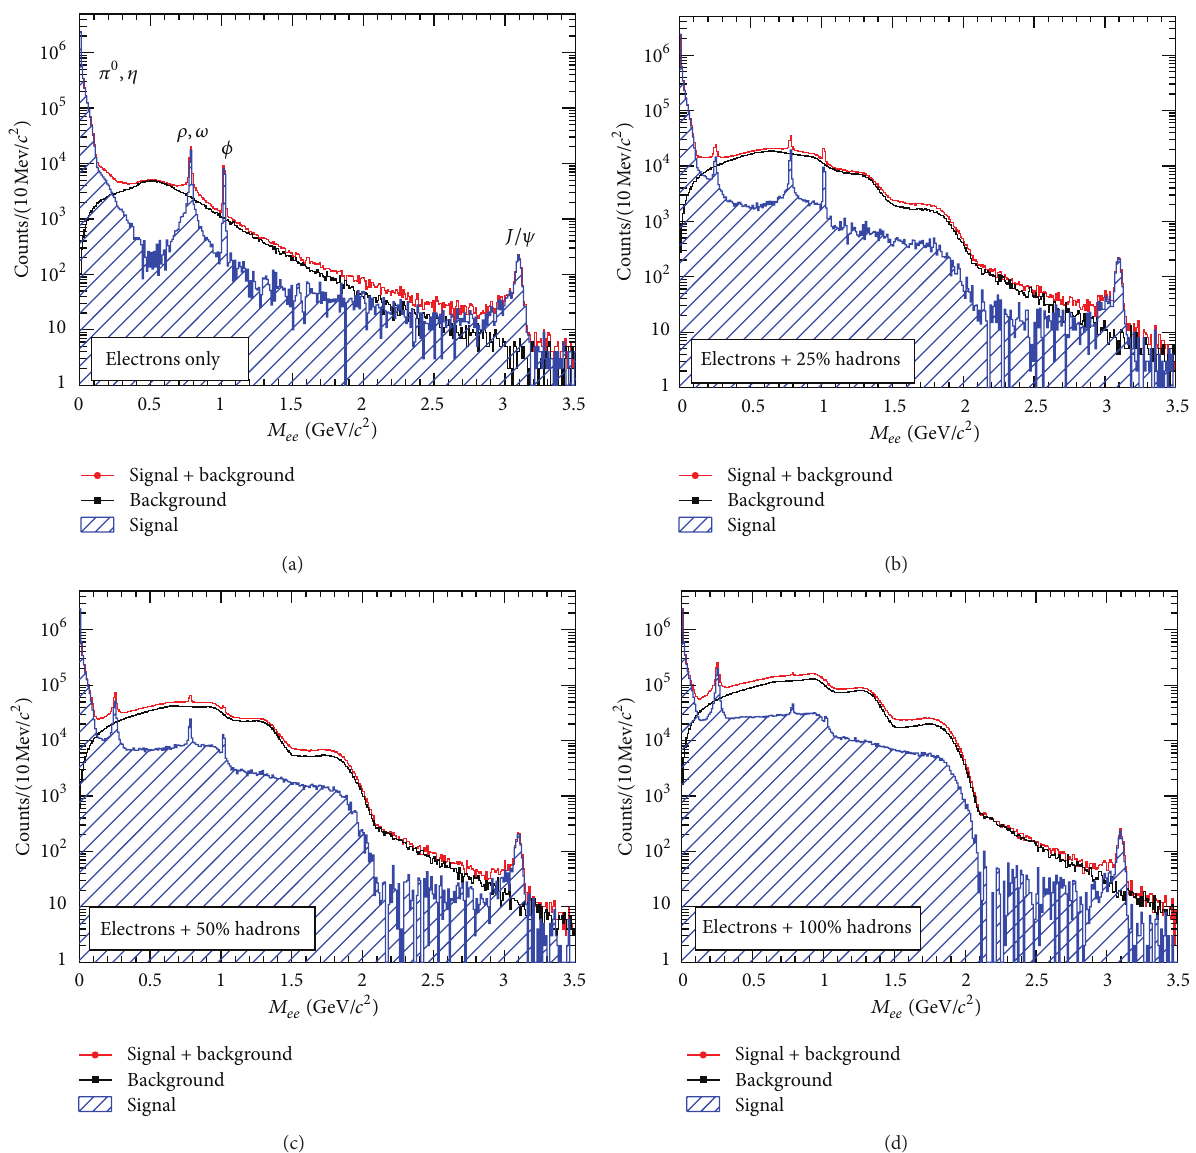
Figure 5: Invariant mass spectrum for foreground (all opposite-sign pairs) and combinatorial background for selected levels of hadron misidentification: (a) “Electrons only,” (b) “Electrons + 25% hadrons,” (c) “Electrons + 50% hadrons,” and (d) “Electrons + 100%